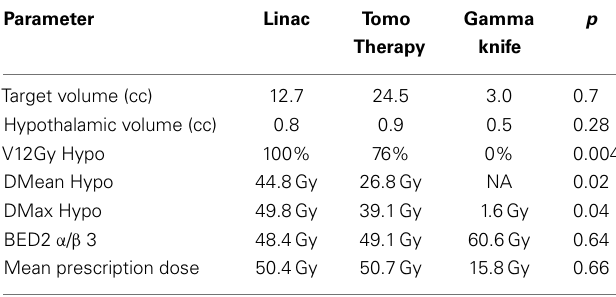
Table 2 | Dosimetric parameters by treatment modality.